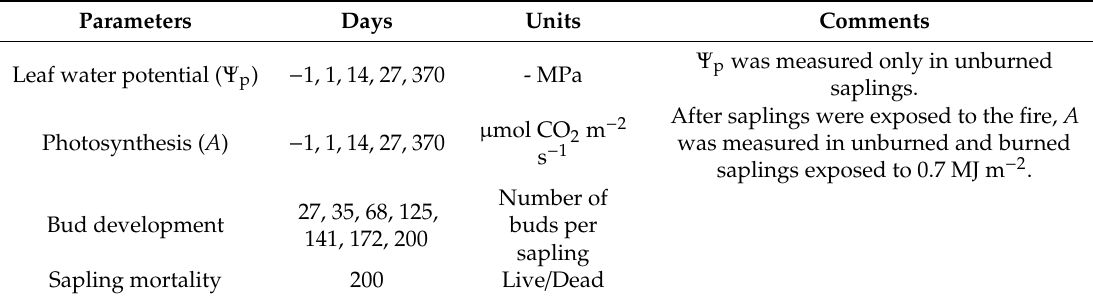
Table 1. List of parameters